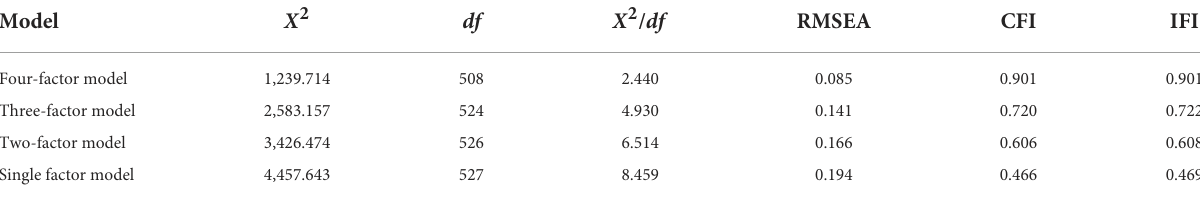
TABLE 1 Result of confirmatory factor